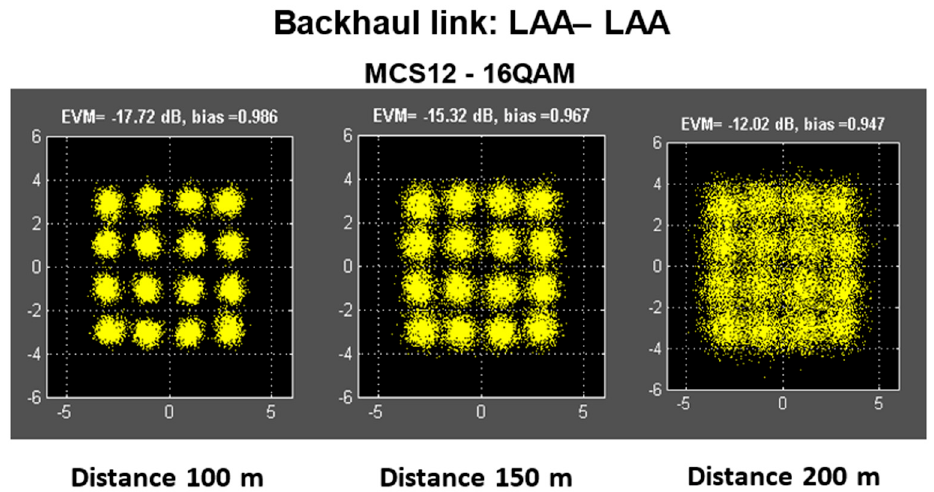
( b ) Figure 7. Highly-directional steerable mmWave antennas: ( a ) modular antenna array architecture and ( b ) lens array antenna scheme. The LAA prototype developed in the framework of the MiWEBA project has an aperture (lens height) of 112 mm and a gain of up to 27 dBi. To demonstrate the feasibility of the proposed LAA in access and backhaul applications, real packet transmissions with different MCSs were performed under field conditions. Three experimental scenarios were investigated: device to device (D2D) linking (single PAA module to single PAA module transmission), access linking (LAA to single PAA